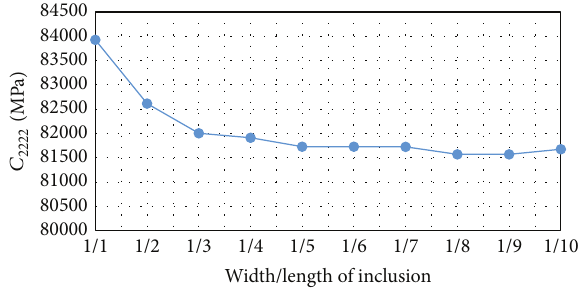
(0) 𝐶 2222 for reinforced plexiglas